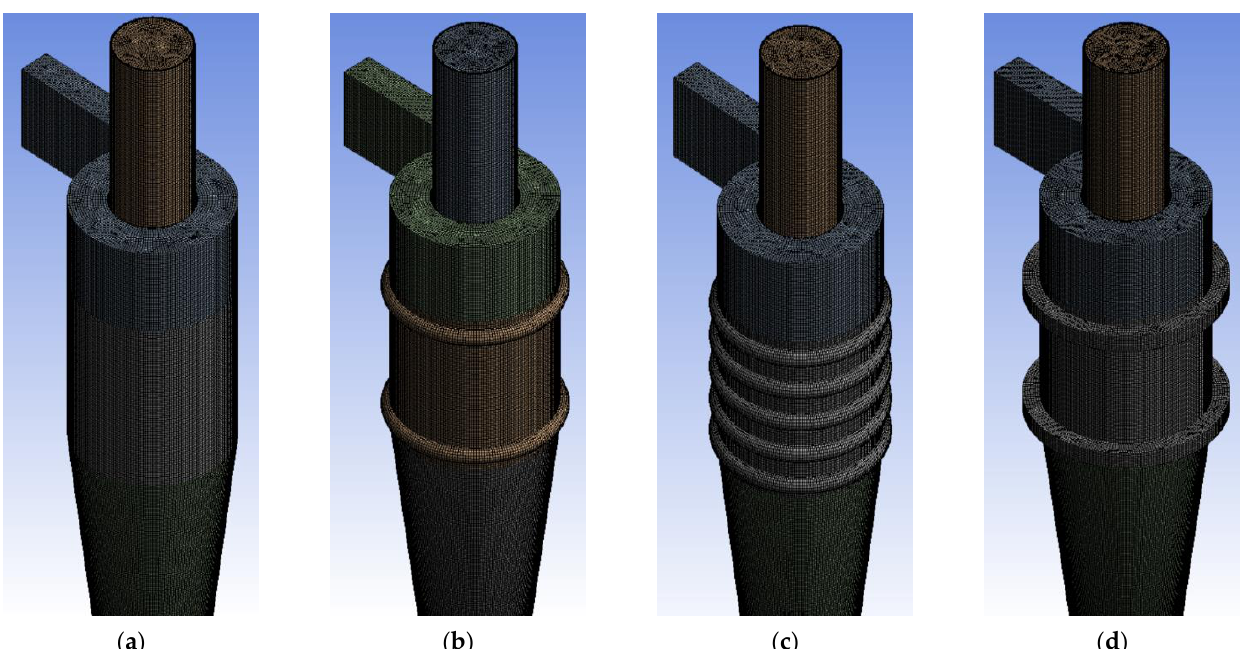
Figure 2. Meshing of cyclone models; ( a ) Model A (Stairmand) cyclone separator, ( b ) Model B cyclone separator, ( c ) Model C cyclone separator, ( d ) Model D cyclone separator. Table 2. Mesh quality parameters of cyclone models A, B, C and D.